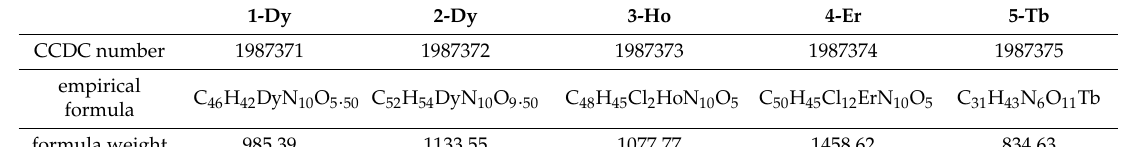
Table 1. Crystal data and structure refinement for 1 – 5